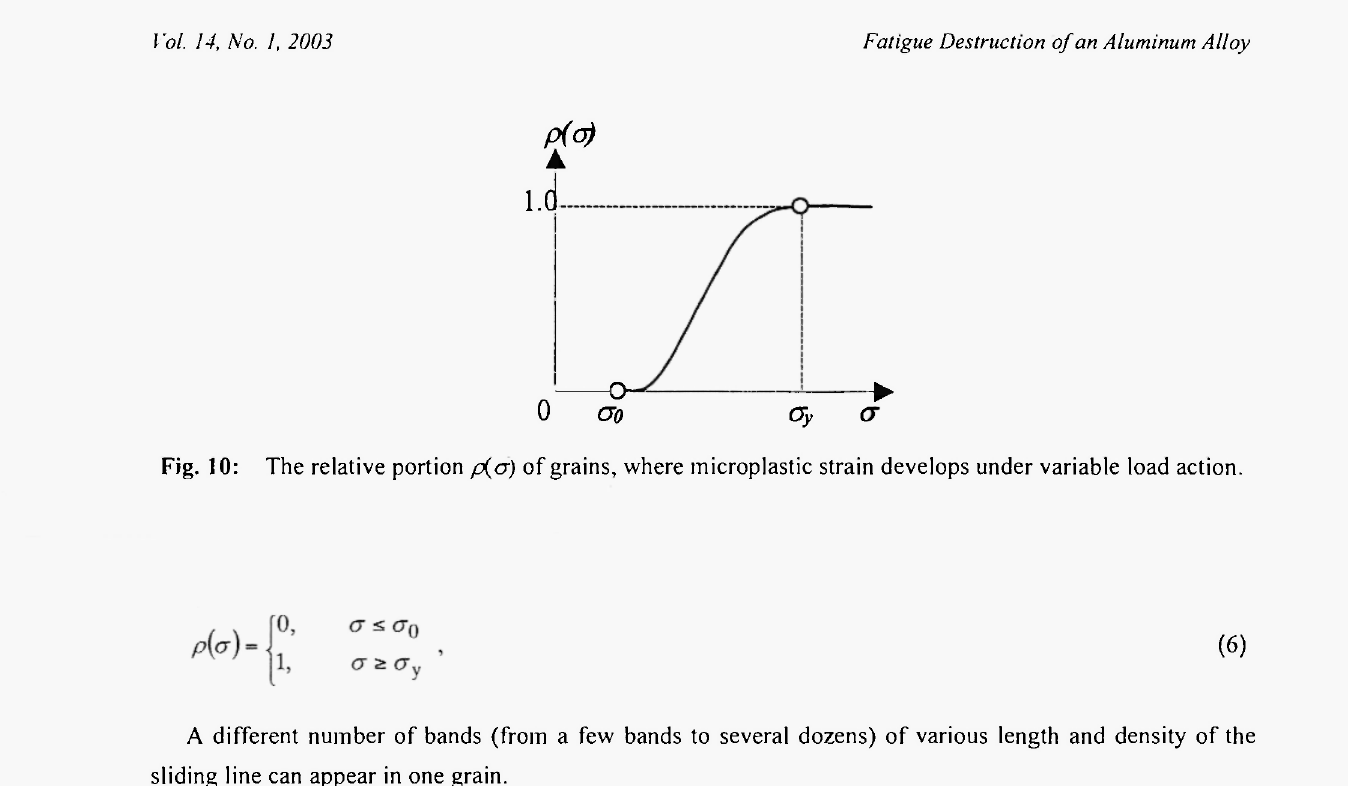
A different number of bands (from a few bands to several dozens) of various length and density of the sliding line can appear in one